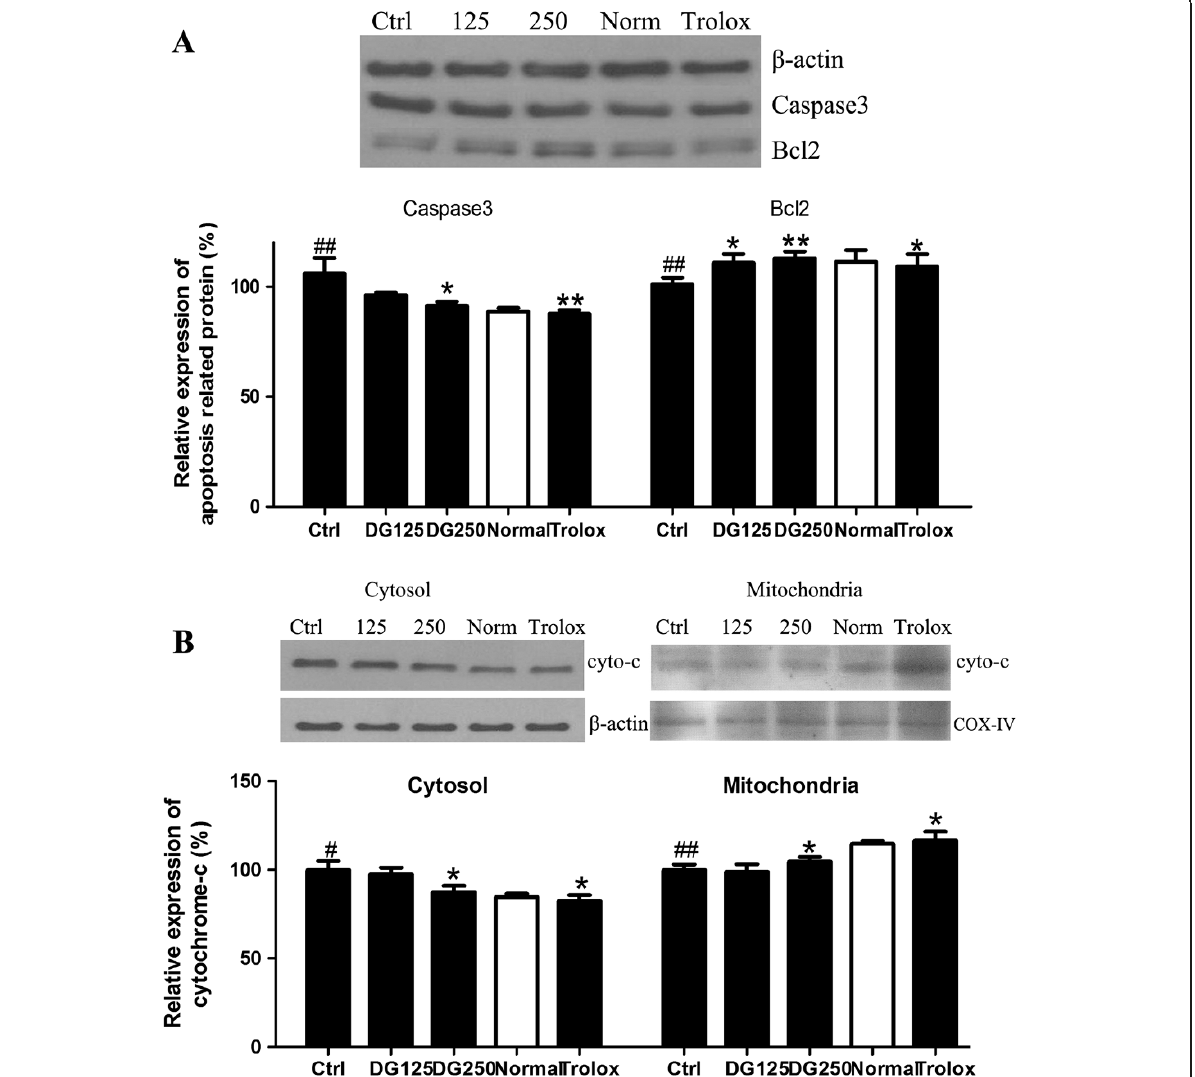
Figure 5 The effect of DG on apoptotic protein expression in H/R-challenged H9c2 cells. After treatment with H/R in the presence or absence of DG, A ) Caspase 3 and bcl 2 expression in total cellular protein extract was detected by Western blot which was normalized by β -actin. B ) Cytochrome c expression in cytosolic fraction (normalized by β -actin) and mitochondrial fraction (normalized by COX-IV) were detected by Western blot. Relative band intensity was calculated by dividing the intensity of each treated sample by that of the control group. The data were expressed as mean ± S.E.M. The figure is a representative of three individual experiments. The data were expressed as mean ± S.E. M. #p < 0.05 and ##p < 0.01 indicated the groups with significant difference when compared to the normoxic group. *p < 0.05 and **p < 0.01 when compared to the control